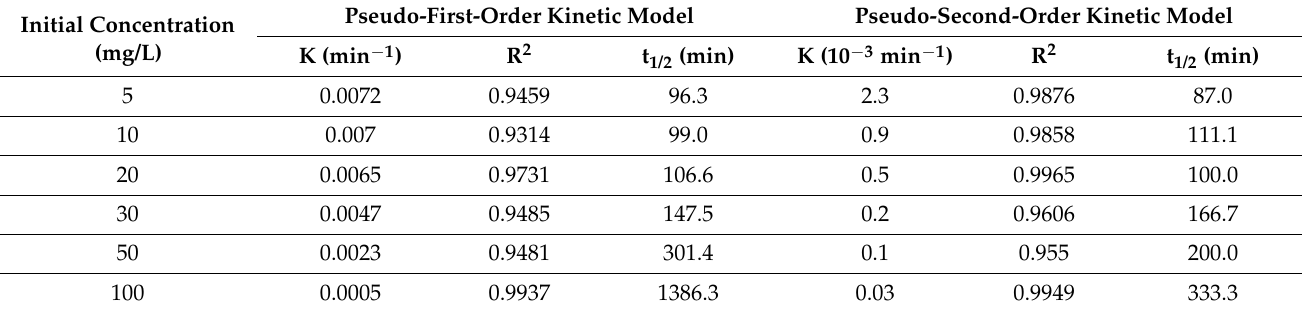
Table 3. TC degradation kinetics parameters with different initial